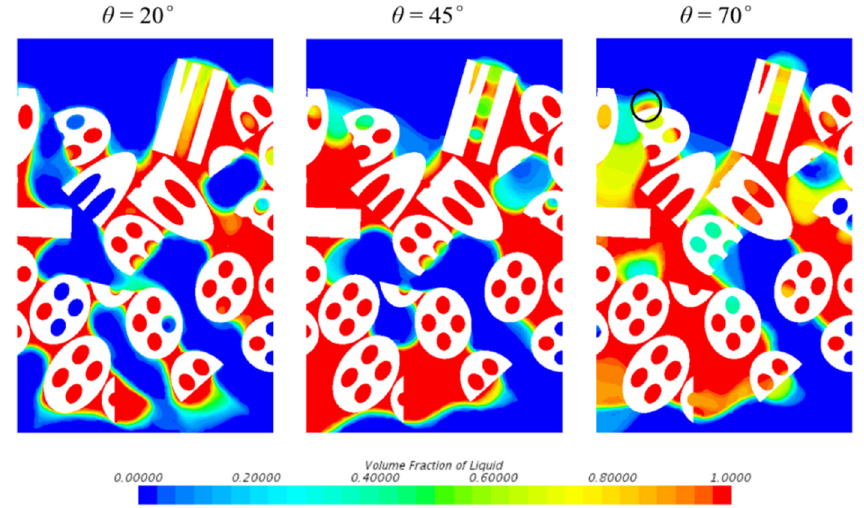
Figure 6. Liquid distributions with di ff erent contact angles ( v G = 0.245 m / s, v L = 0.008 m / s).